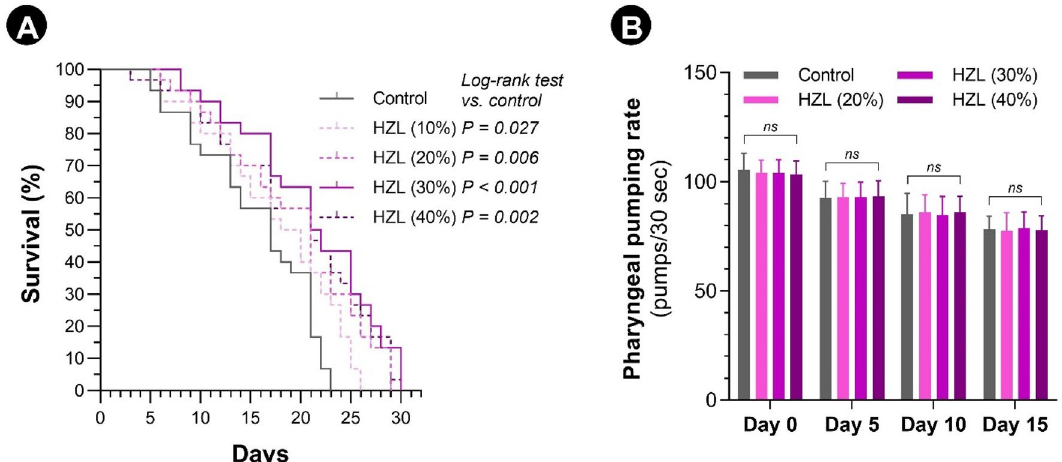
Figure 5. Lifespan extension and food intake behavior of C. elegans supplemented with HydroZitLa (HZL). ( A ) Kaplan–Meier survival curves compared between C. elegans supplemented with HydroZitLa (10%–40% v/v) and non-supplemented control. Supplementation with 10%, 20%, 30%, and 40% v/v HydroZitLa significantly increased the median lifespan of nematodes compared with non-supplemented control. The highest lifespan extension was with 30% v/v HydroZitLa supplementation. Median survival time of non-supplemented control worms was 16 days. Supplementations with HydroZitLa at 10%, 20%, 30%, and 40% significantly increased the median survivals to 18.5 (15.6% increase), 19.5 (21.9% increase), 21.5 (34.4% increase), and 21.0 (31.3% increase) days, respectively. ( B ) Pharyngeal pumping rates measured at days 0, 5, 10, and 15 were not significantly different between supplemented and non-supplemented worms. NS: not